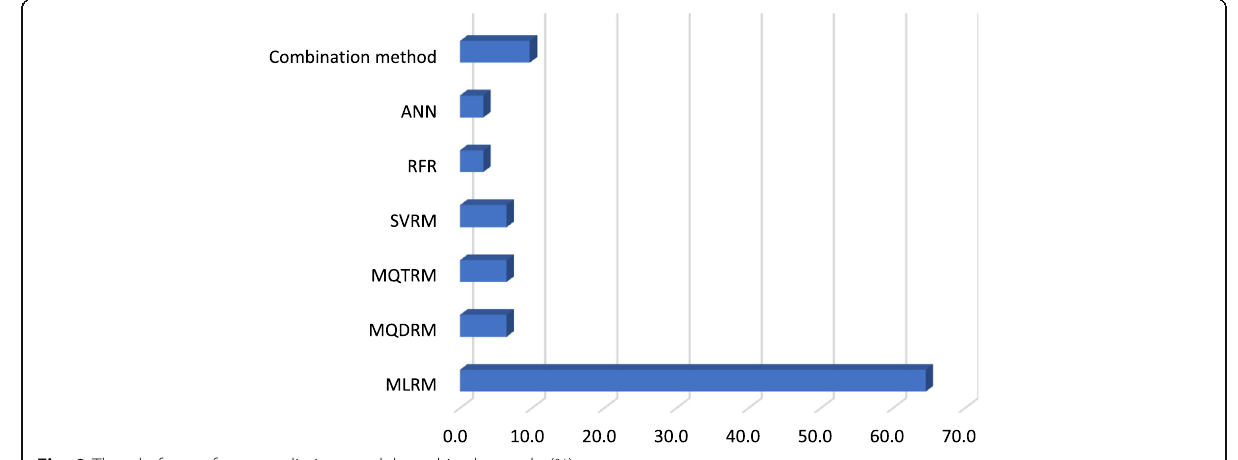
Fig. 9 The platform of age prediction model used in the study